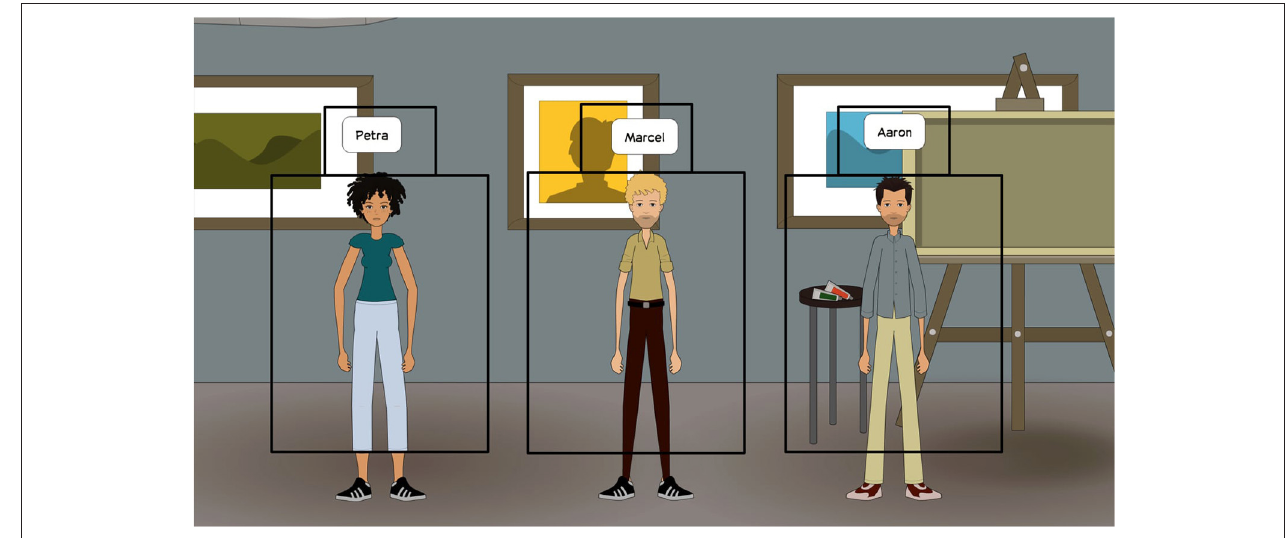
FIGURE 1 | An example of a visual scene used in Experiments 1 and 2. Black boxes indicate regions of interest and were not seen by